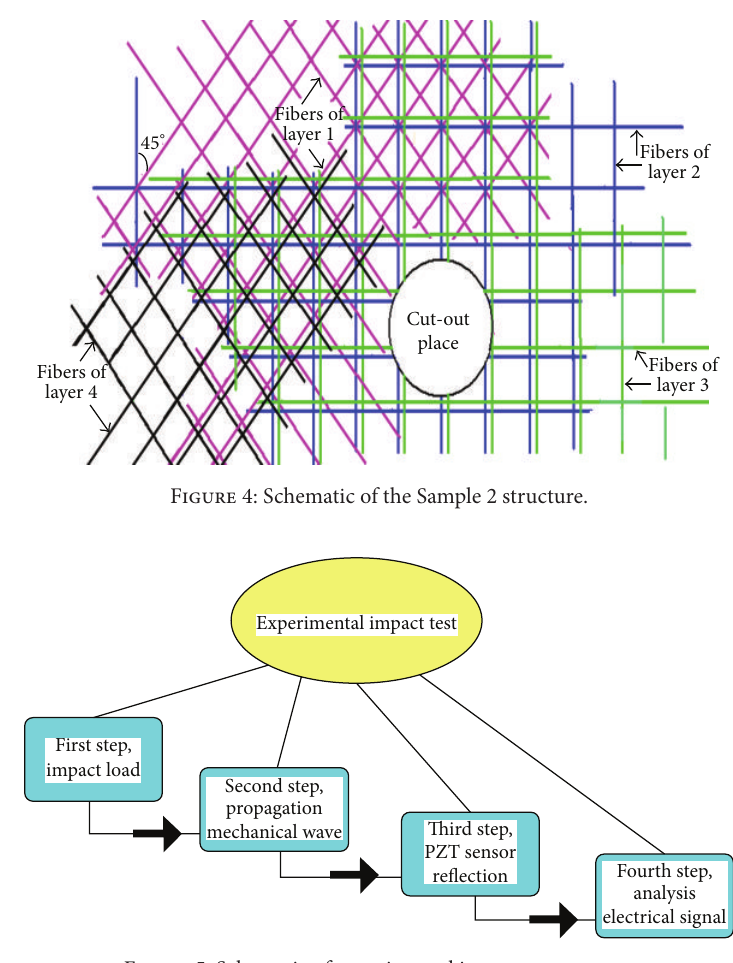
Figure 5: Schematic of experimental impact test process.